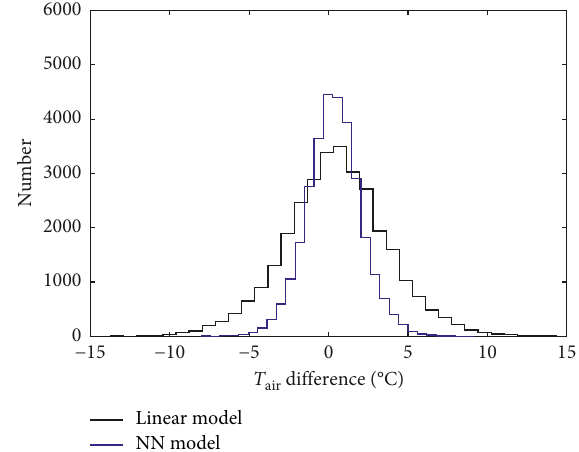
Figure 3: Histogram of differences between estimated and ob- served T air for linear (black) and NN (blue) model